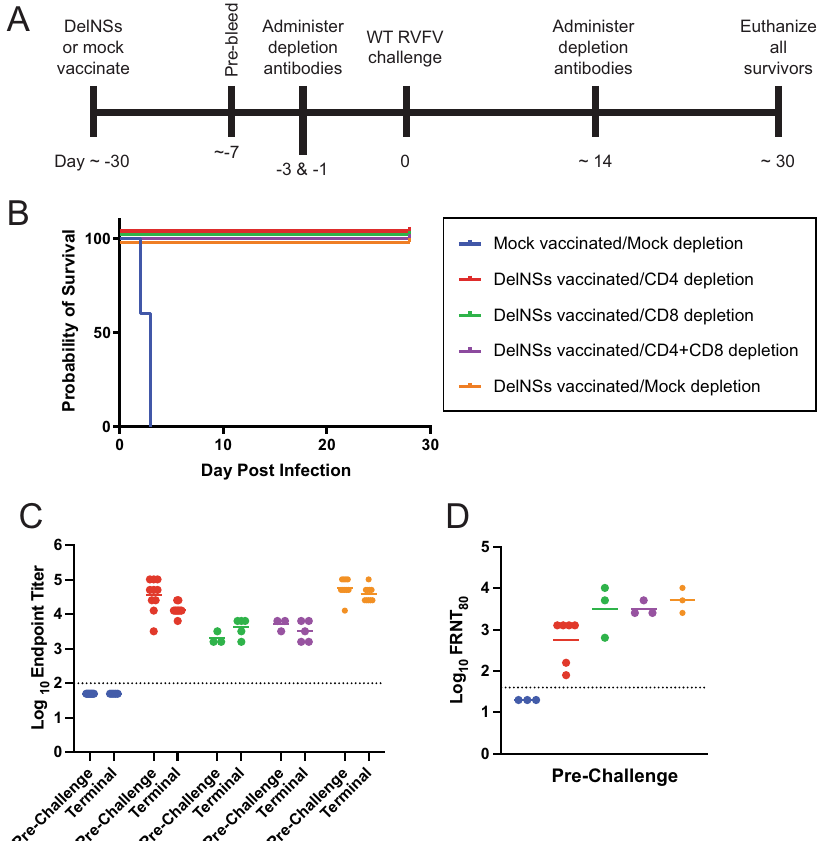
Fig. 1 RVFV-speci fi c memory T cells are dispensable for survival in the presence of pre-existing RVFV-speci fi c antibodies. Mice ( n = 5 – 10 per experimental group) were vaccinated with 2 × 10 5 TCID 50 of DelNSsRVFV or mock-vaccinated then depleted of CD4 + , CD8 + , CD4 + /CD8 + cells or mock-depleted, then challenged with 2 × 10 5 TCID 50 of WT RVFV ( A ) and monitored for survival ( B ). Endpoint titers of RVFV-speci fi c antibodies by ELISA ( C ) or neutralizing antibody titers ( D ) were measured prior to and/or after WT challenge. The dotted line is the LOD (100 for ELISA, 40 for FRNT 80 ). Negative values were plotted at 50 and 20, respectively. The geometric mean titer is noted for each